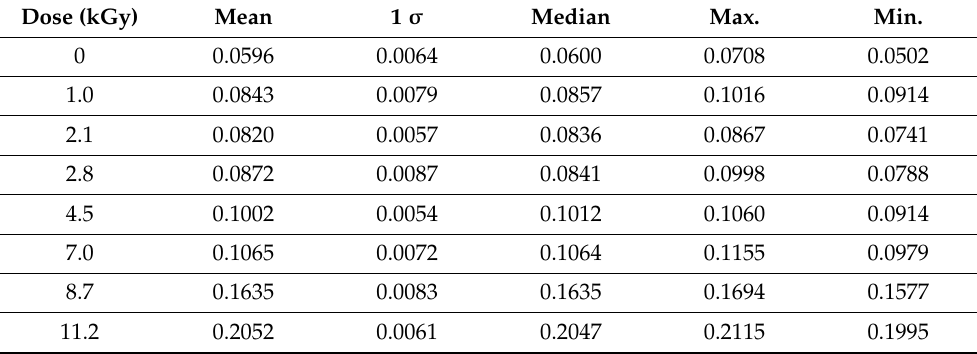
Figure 25. MLR of the PLA resins irradiated over 11–120 kGy gamma dose (Hot Press Conditions: 193 °C, 12 min hold time). Table 8. Statistical analysis of the MLR of the PLA resins irradiated with an 11 – 120 kGy gamma Table 7. Statistical analysis of the MLR of the PLA resins irradiated with a 0–11 kGy gamma dose.